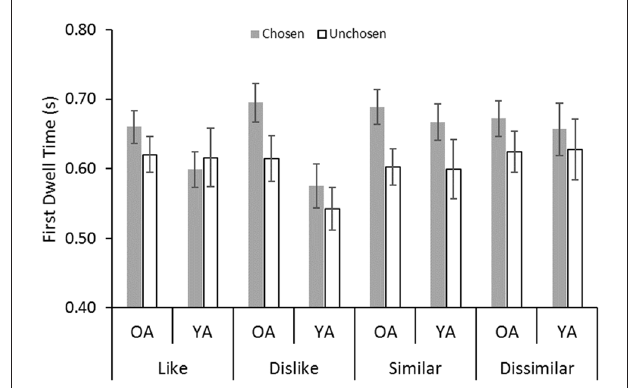
FIGURE 4 | Average dwell duration values in the remaining time epochs: YA, younger adult; OA, older adult. Error bars represent standard